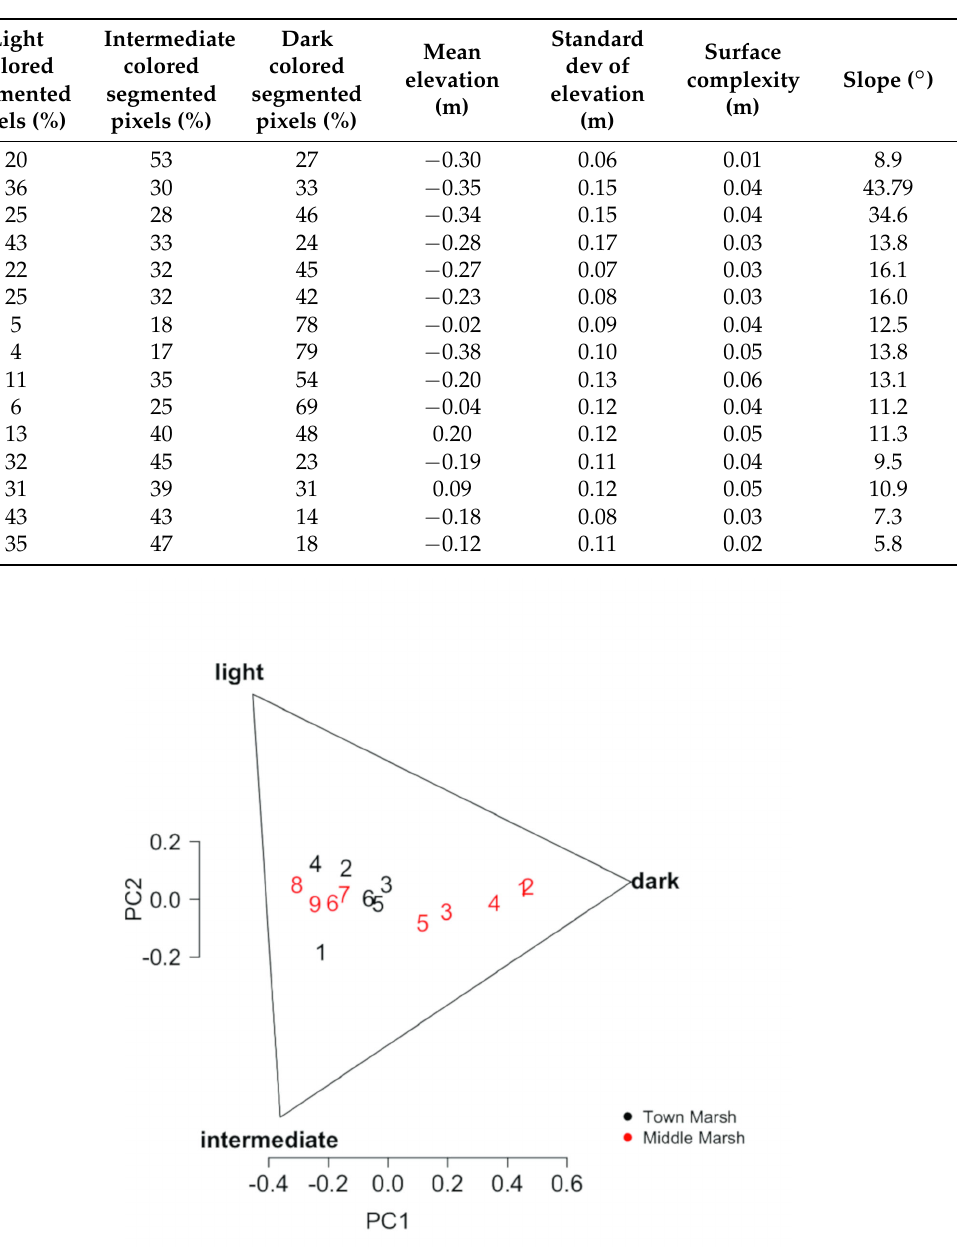
Figure A3. PCA on proportions of digital count RGB pixel values classified as light, intermediate, and dark colored pixels for each patch